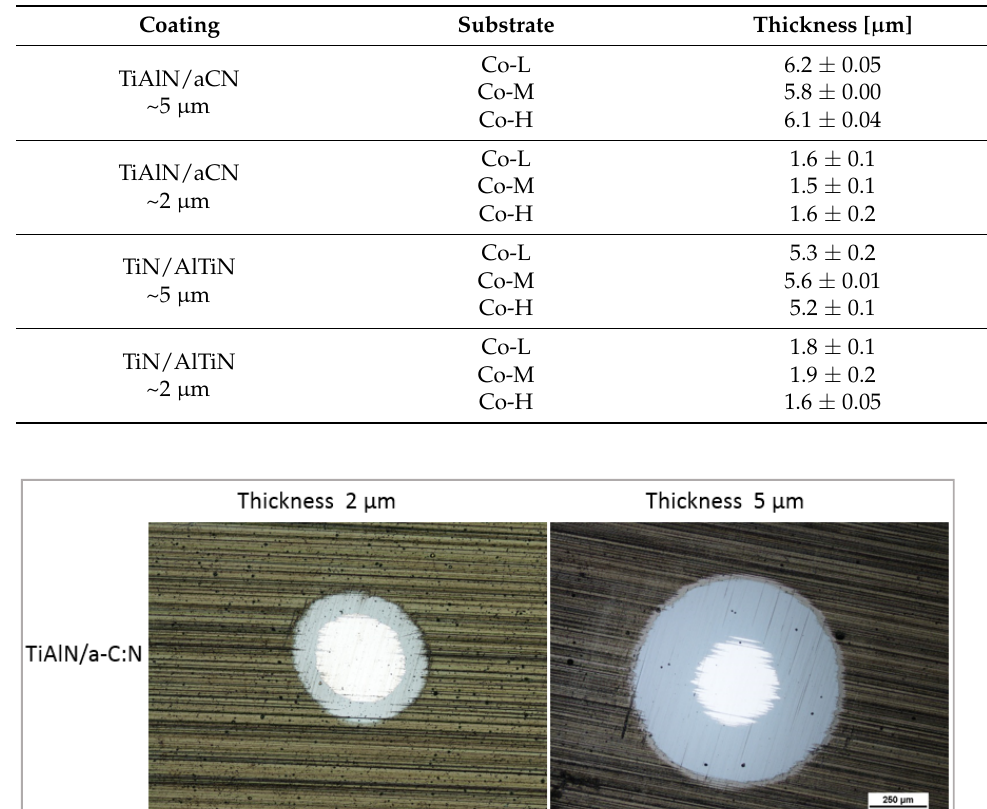
Table 4. Summary of coating thickness obtained in the ball wear test.